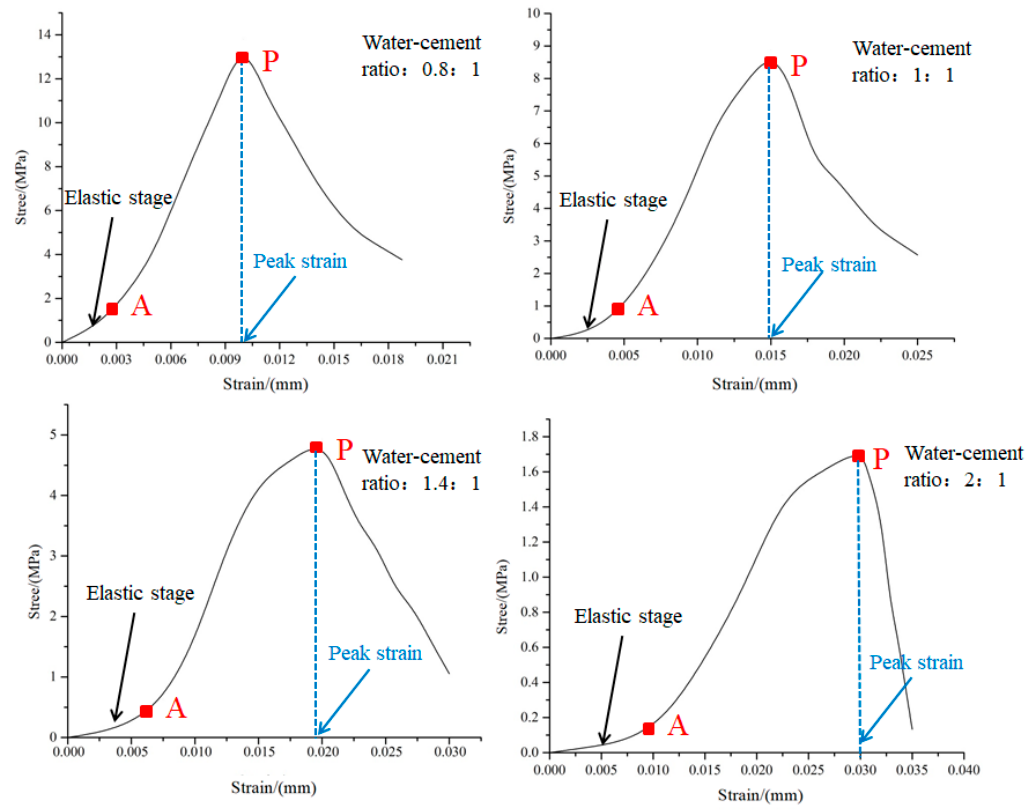
ff erent water–cement